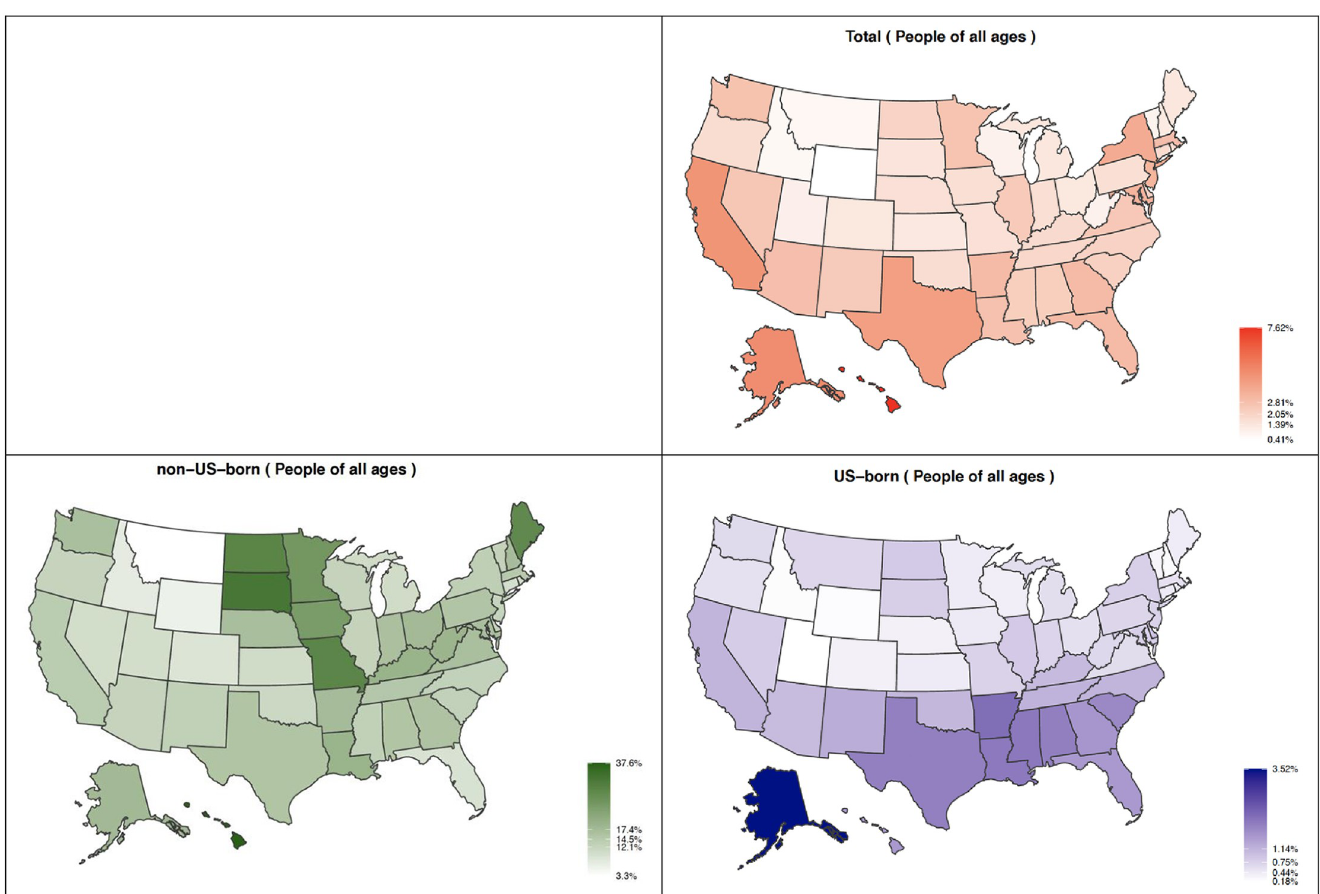
Fig 1. Estimated prevalence of latent tuberculosis infection by state and nativity (US-born or non-US–born), United States, 2015. The numbers in the legend are minimum, 25%, 50%, 75% quintiles, and maximum values. Software and source: open-source R and “usmap” package were used to create the maps. Both R software and the “usmap” package are license under GPL-3 | file LICENSE and free to use. [https://www.r-project.org/Licenses/; https://cran.r-project.org/web/packages/ usmap/usmap.pdf].